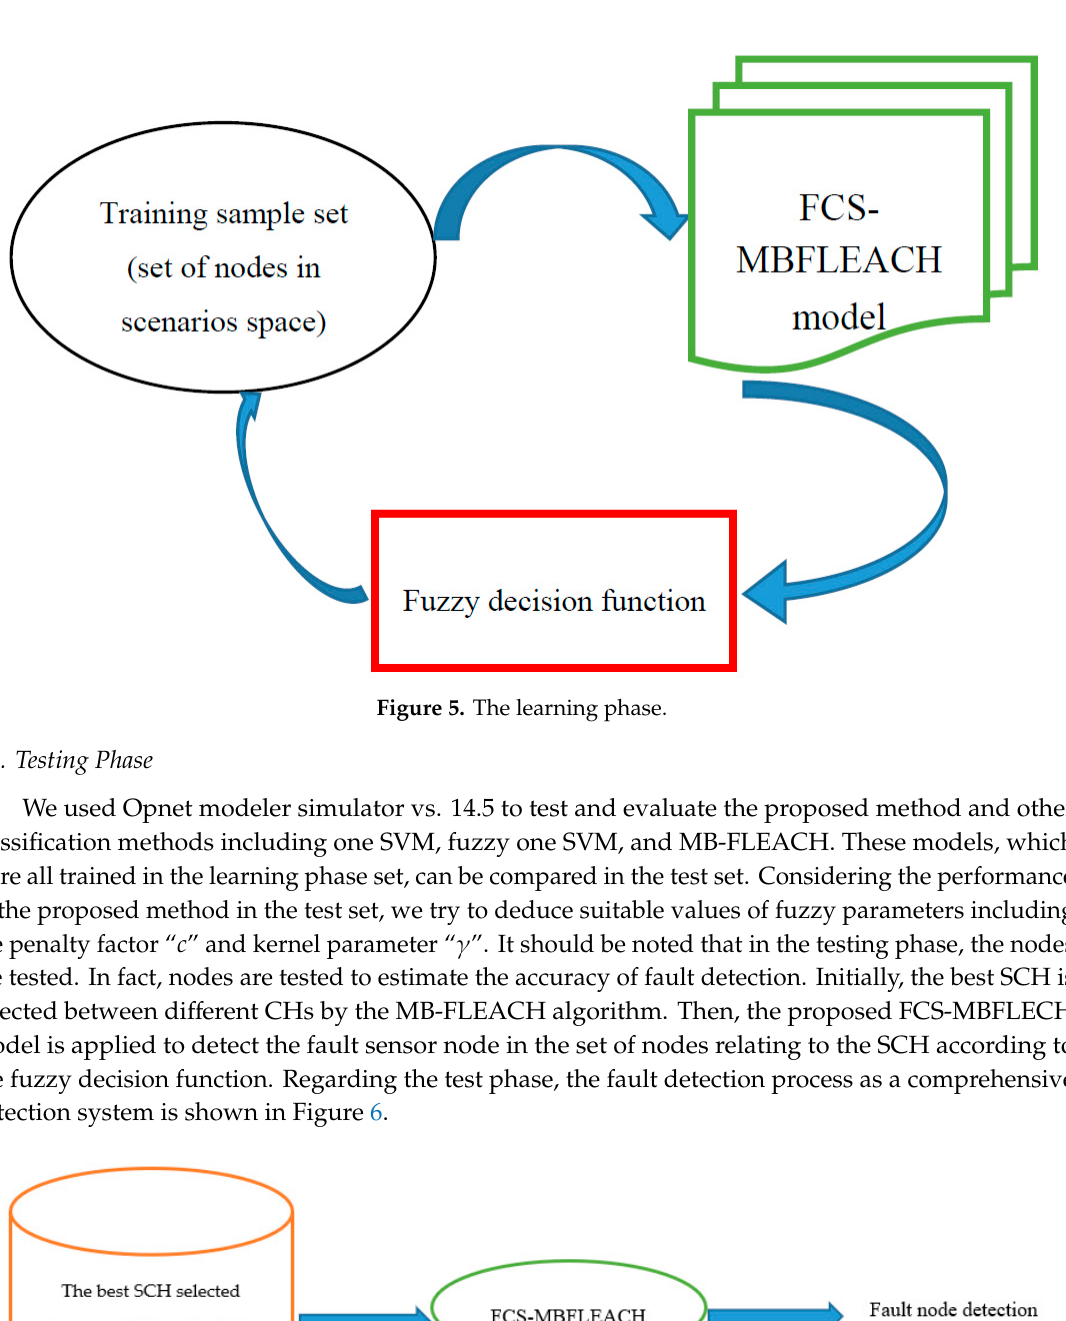
Figure 5. The learning phase.